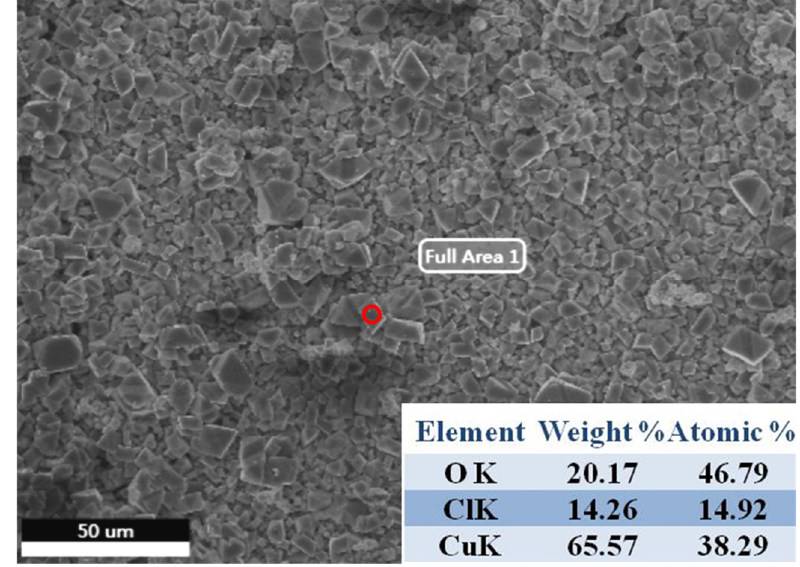
Figure 8. EDS analysis of the corrosion products.